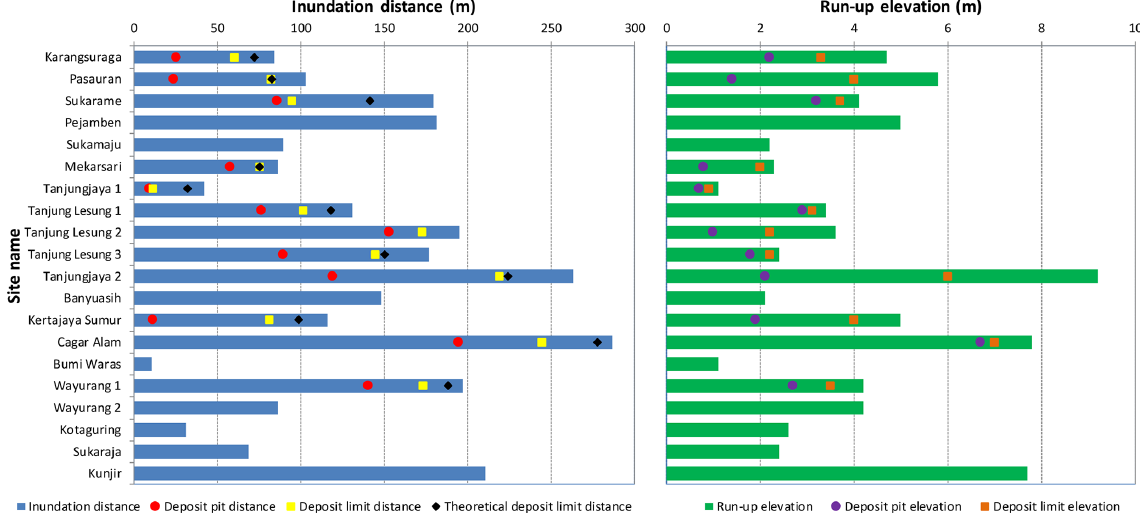
Figure 6. Positions of deposit pits and deposit limit compared to inundation distance and run-up elevation. Theoretical approach for tsunami deposit only available for distance not for elevation.